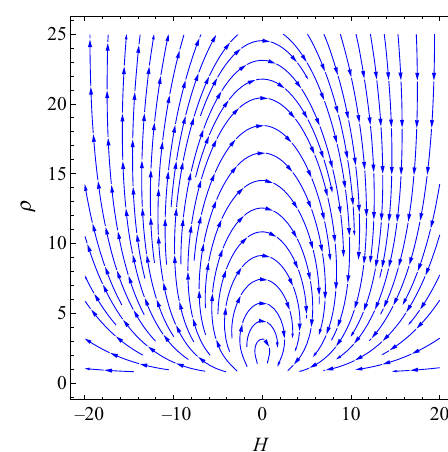
5, ω = − 0 . 98 , (cid:3) ∗ m ∈ ( 0 . 2 , 0 . 5 ) , c 2 s ∈ ( 0 , 0 . 5 ] . Right panel only corre- sponds to closed curvature mode with the same numerical values except μ = 1, 0 < ρ ∗ < 0